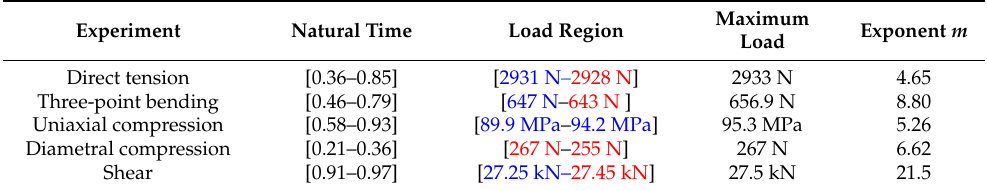
Table 1. The characteristics of the interval during which the F -function expressed in terms of the Natural Time concept is governed by a power law of the form: F ( χ ) = A χ m .